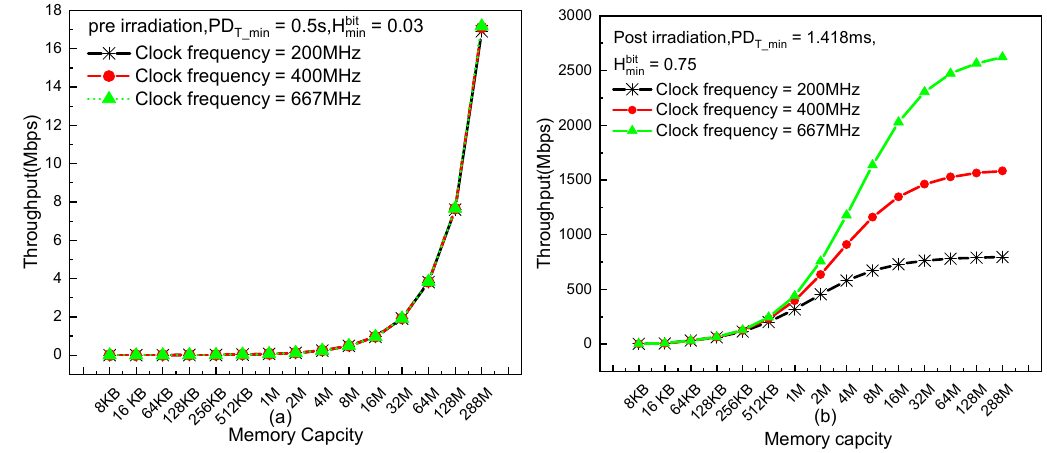
Figure 7. Maximum throughput at di ff erent memory capacities and clock frequencies: ( a ) preirradiation and ( b ) under 2 Mrad( SiO 2 ).